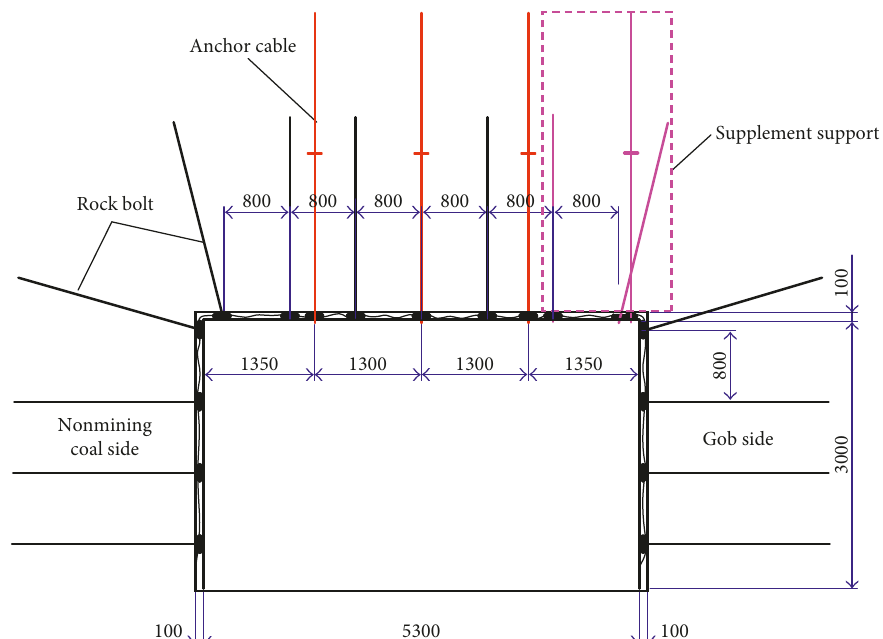
Figure 10: Support parameters of the gob-side entry retaining (unit: